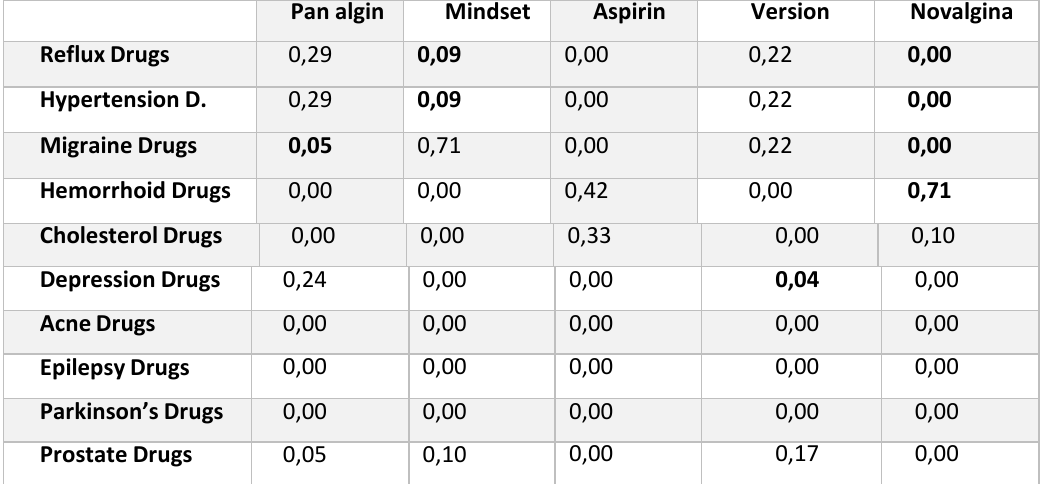
Reflux Drugs Hypertension D.